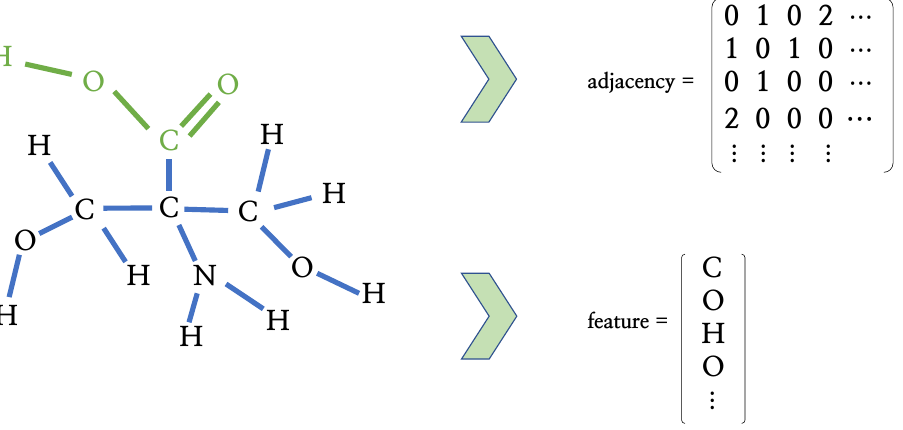
Figure 8. The example of the process representing molecules in graph format. When a molecule has N atoms, elements of the adjacency matrix A ∈ R N × N denote the bond type between atomic pairs and elements of the feature vector f ∈ R N × 1 , which denotes the atomic numbers. We can see that a carboxylic group (marked in green) is represented in the adjacency matrix and feature